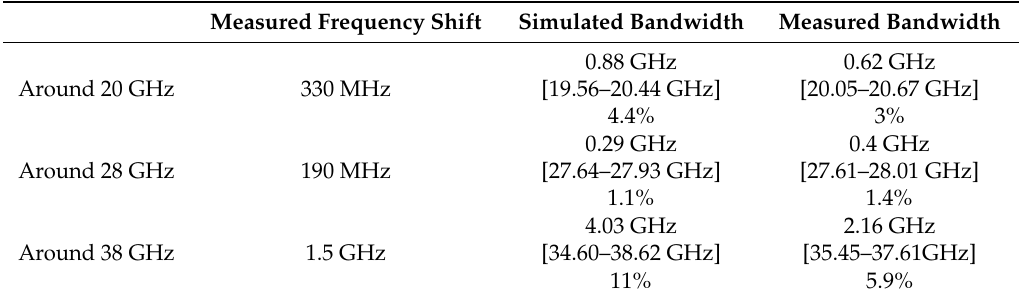
Table 4. Tri-Band S 11 Parameter Characteristics.